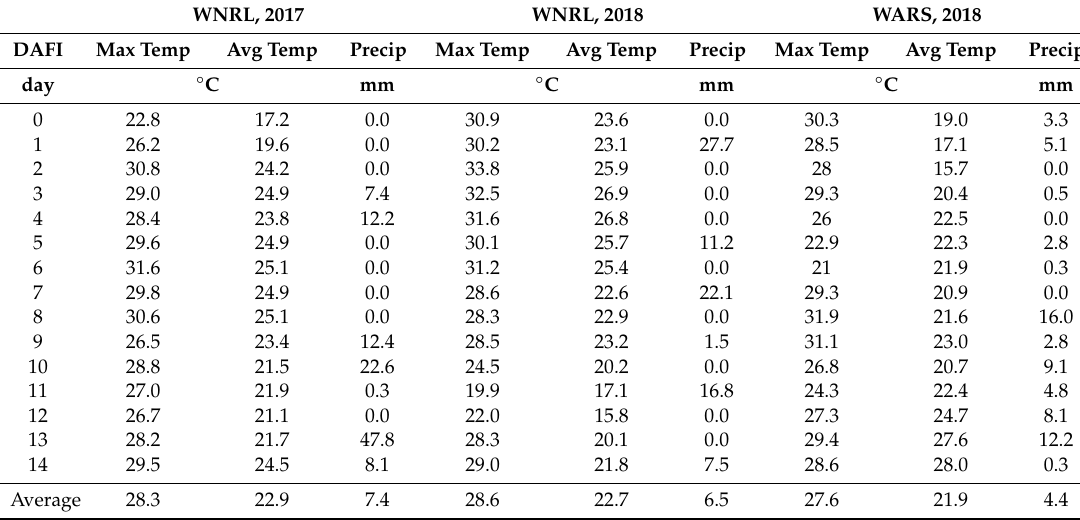
Table 2. Daily maximum temperature, daily average temperature, and daily precipitation from 0 days after flood initiation (DAFI) through 14 DAFI at the Waterman Agricultural and Natural Resources Laboratory (WNRL) in 2017 and 2018, and the Western Agricultural Research Station (WARS) in